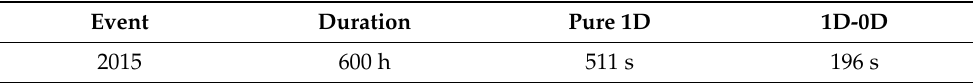
Table 2. Computational times for 2015 flood event simulated in the Ebro River with the 1D-0D model and the pure 1D